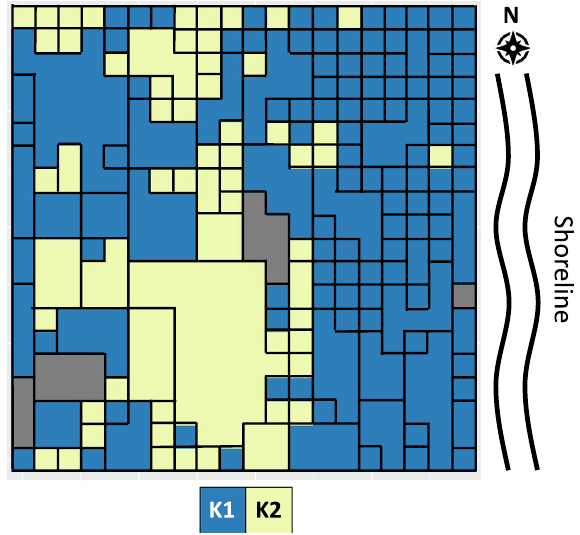
Figure 2. Geographic distribution of individual Rhizophora mangle trees within the 400 m 2 parcel of forest on Fort Cay as assigned by K-means clustering analysis. Black outlines demark individual trees and gray squares represents no tree present (A13) or samples that did not sequence (I10, Q16, T17).